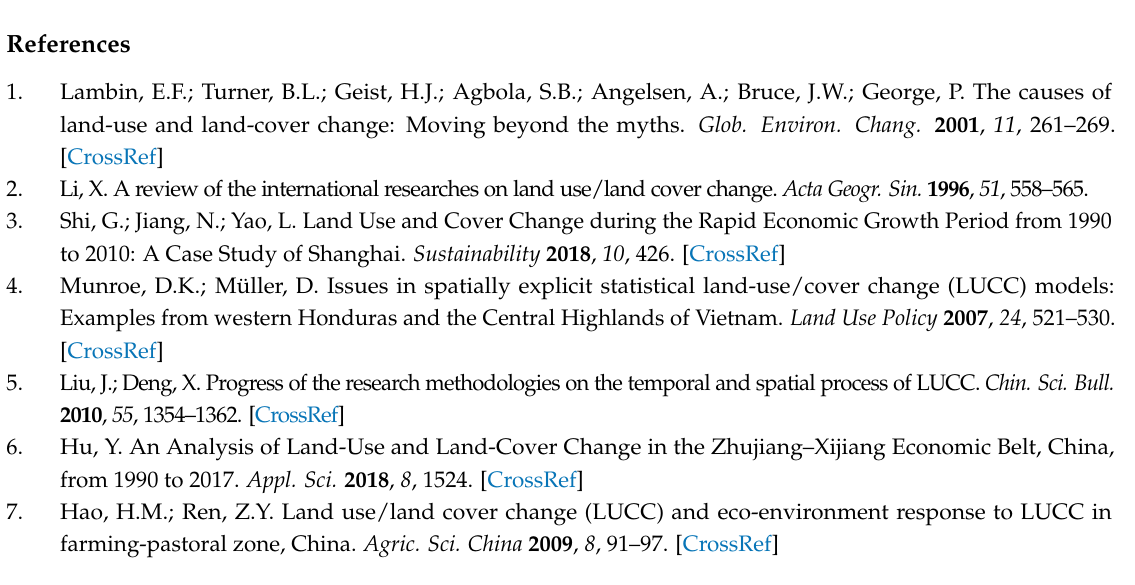
Figure A1. Density of service facility: ( a ) Density of commercial service facility; ( b ) Density of another service facility; ( c ) Density of transportation service facility.